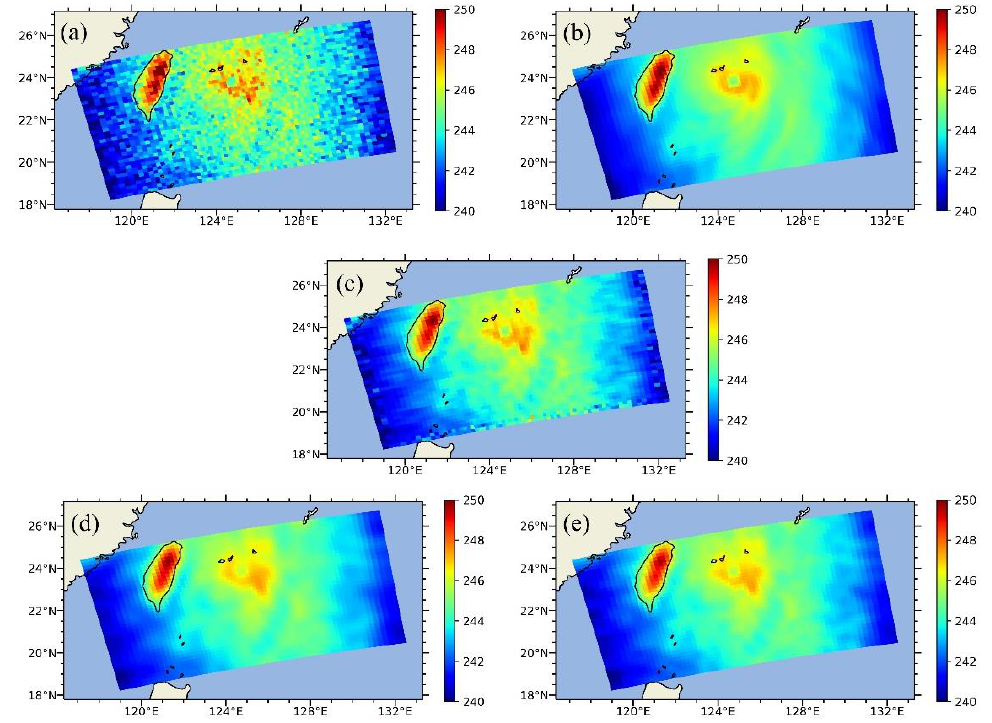
Figure 8. ( a ) Simulated brightness temperature at channel 6 with 2.2 AGF; ( b ) simulated brightness temperature with 3.3 AGF (true without noise); ( c ) brightness temperature resampled from ( a ) by BGI; ( d ) brightness temperature resampled from ( a ) by AAPP; ( e ) brightness temperature resampled from ( a ) by modified AAPP. The unit of brightness temperature is K.